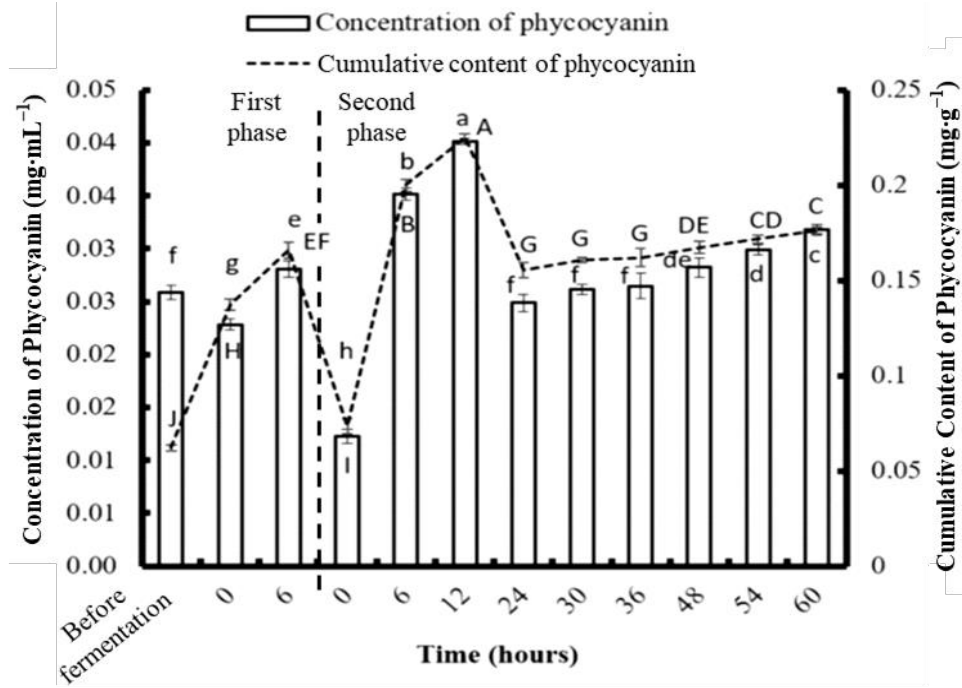
Figure 7. The effect of different fermentation times on the concentration and content of phycocyanin in Colaconema formosanum before and during two-phase fermentation with Pseudoalteromonas haloplanktis , ATCC 14393. Lowercase letters (a, b, c . . . ): concentration of phycocyanin between each fermentation time; uppercase letters (A, B, C . . . ): content of phycocyanin between each fermentation time ( n = 3, Duncan’s test, p < 0.05).